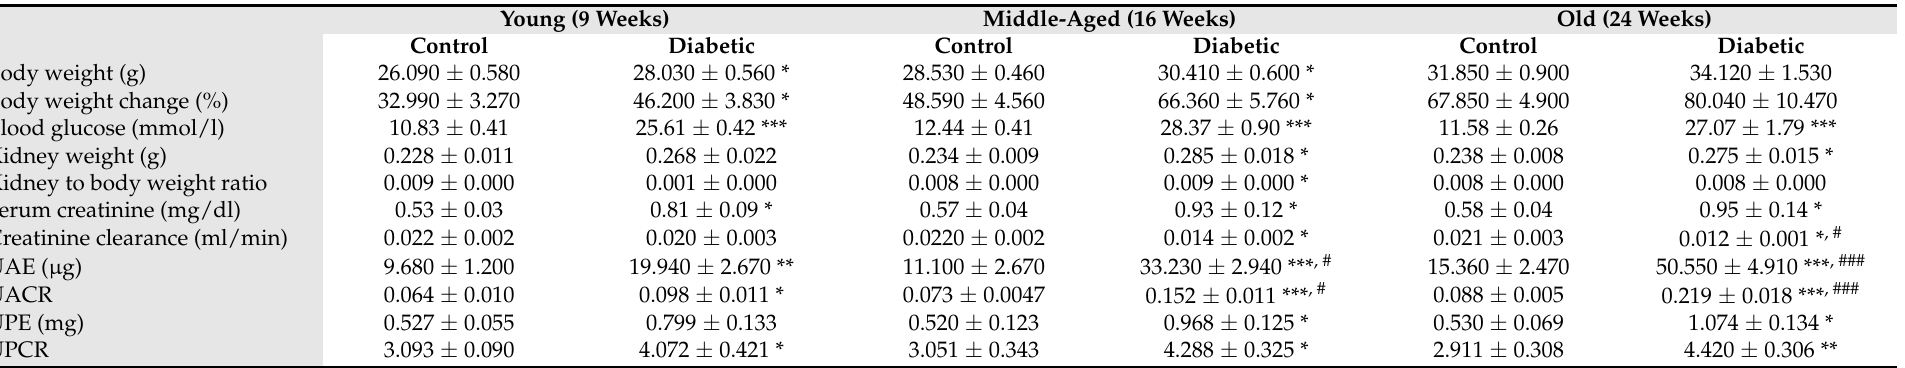
Table 1. Physical and biochemical characteristics of diabetic and control mice of different age groups. The diabetic group and normal control groups were represented by the HFD-STZ-treated mice and the LFD-vehicle-treated mice, respectively. Data were presented as means ± SEM, n = 6. A p -value < 0.05